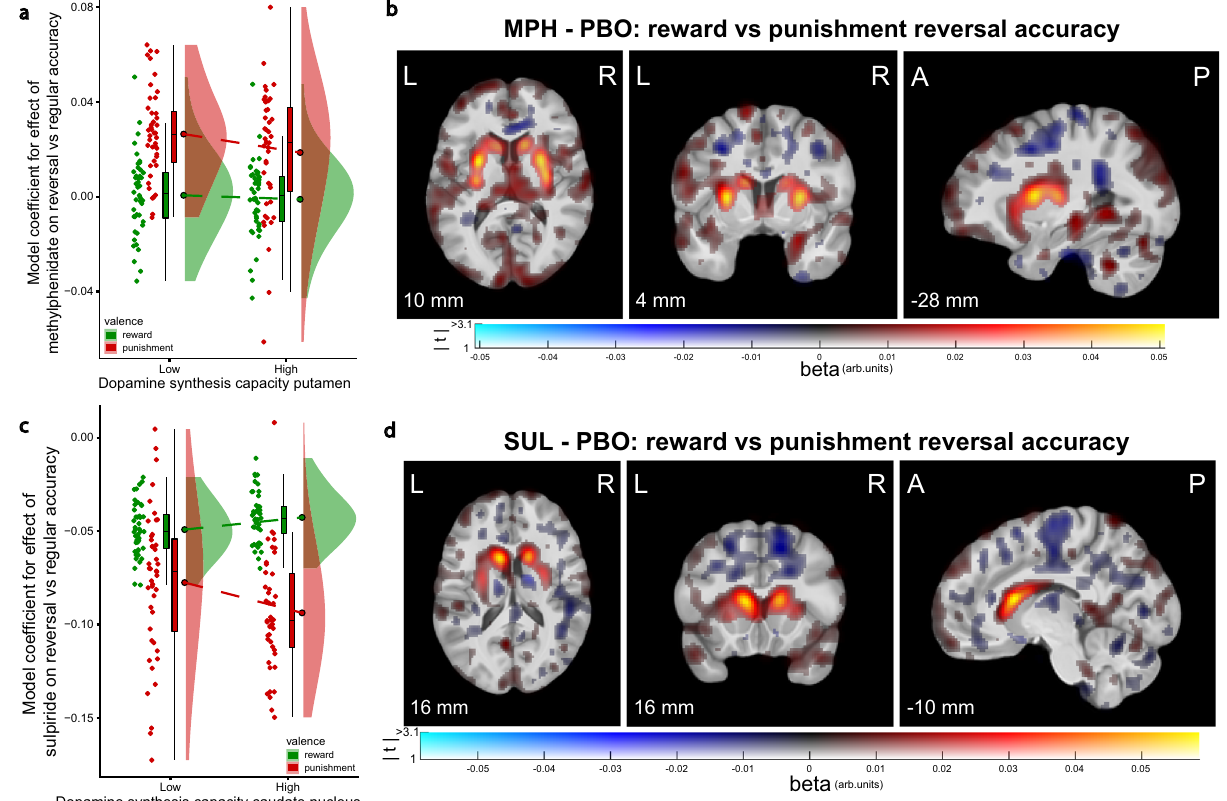
Fig. 5 | Relationship between dopamine synthesis capacity and drug effects (relative to placebo) on reward versus punishment reversal-learning perfor- mance. a Model coef fi cients for the effect of methylphenidate on reward and punishment reversal accuracy for participants with low and high dopamine synthesis capacity (median split for visualization). b Methylphenidate increased reward versus punishment reversal accuracy to a greater degree in participants withhigherstriataldopaminesynthesiscapacity.Voxel-wisecovariationanalysisof